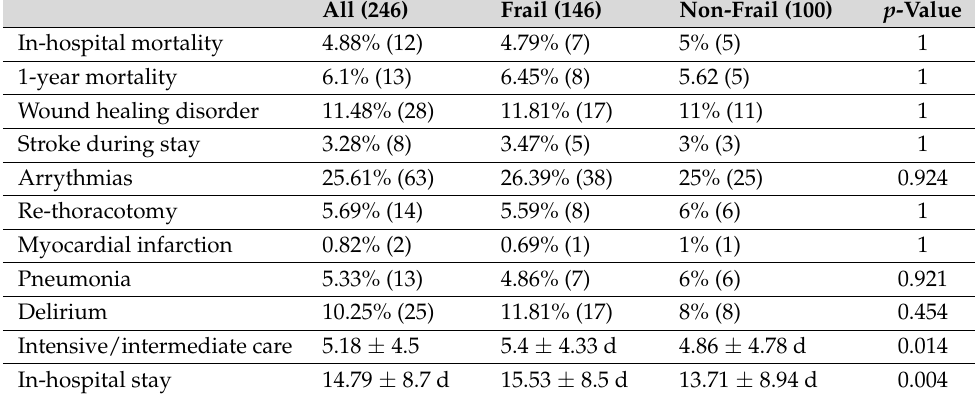
Table 2. Complications and